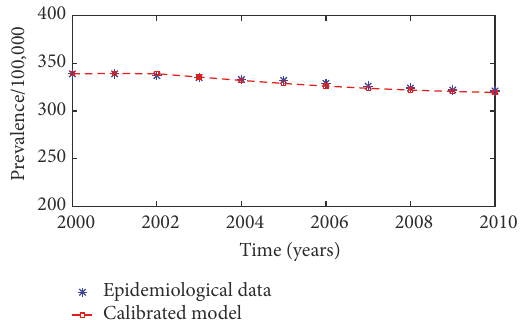
Figure2: Model simulationcalibratedagainst tuberculosisprevalence data in Nigeria: The figure shows the tuberculosis prevalence curve of the model, calibrated with 2000–2010 data, compared with the data estimates from WHO in that period. The model prevalence curve is obtained by solving (1) to (12), using the initial conditions in (13) and parameter values in Table 1. The goodness-of-fit measure (𝑅 2 ) for simulation trajectories was evaluated and found to be